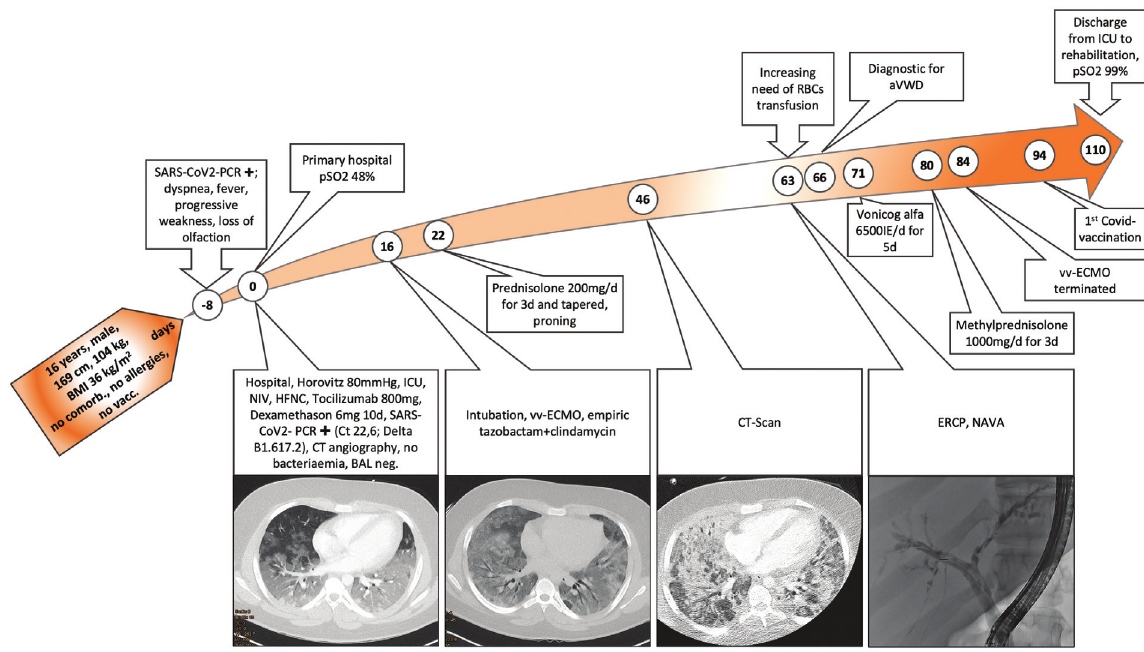
Fig. 1 Presentation of patient ’ s time course of disease since hospital admission (day 0). ICU, intensive care unit; NIV, noninvasive ventilation; HFNC, high- fl ow nasal cannula; PCR, polymerase chain reaction; BAL, bronchial lavage sampling; vv-ECMO, veno-venous extracorporeal membrane oxygenation; RBC, red blood cell transfusion; ERCP, endoscopic retrograde cholangiopancreatography; NAVA, neurally adjusted ventilator assist; pSO 2 , partial oxygen